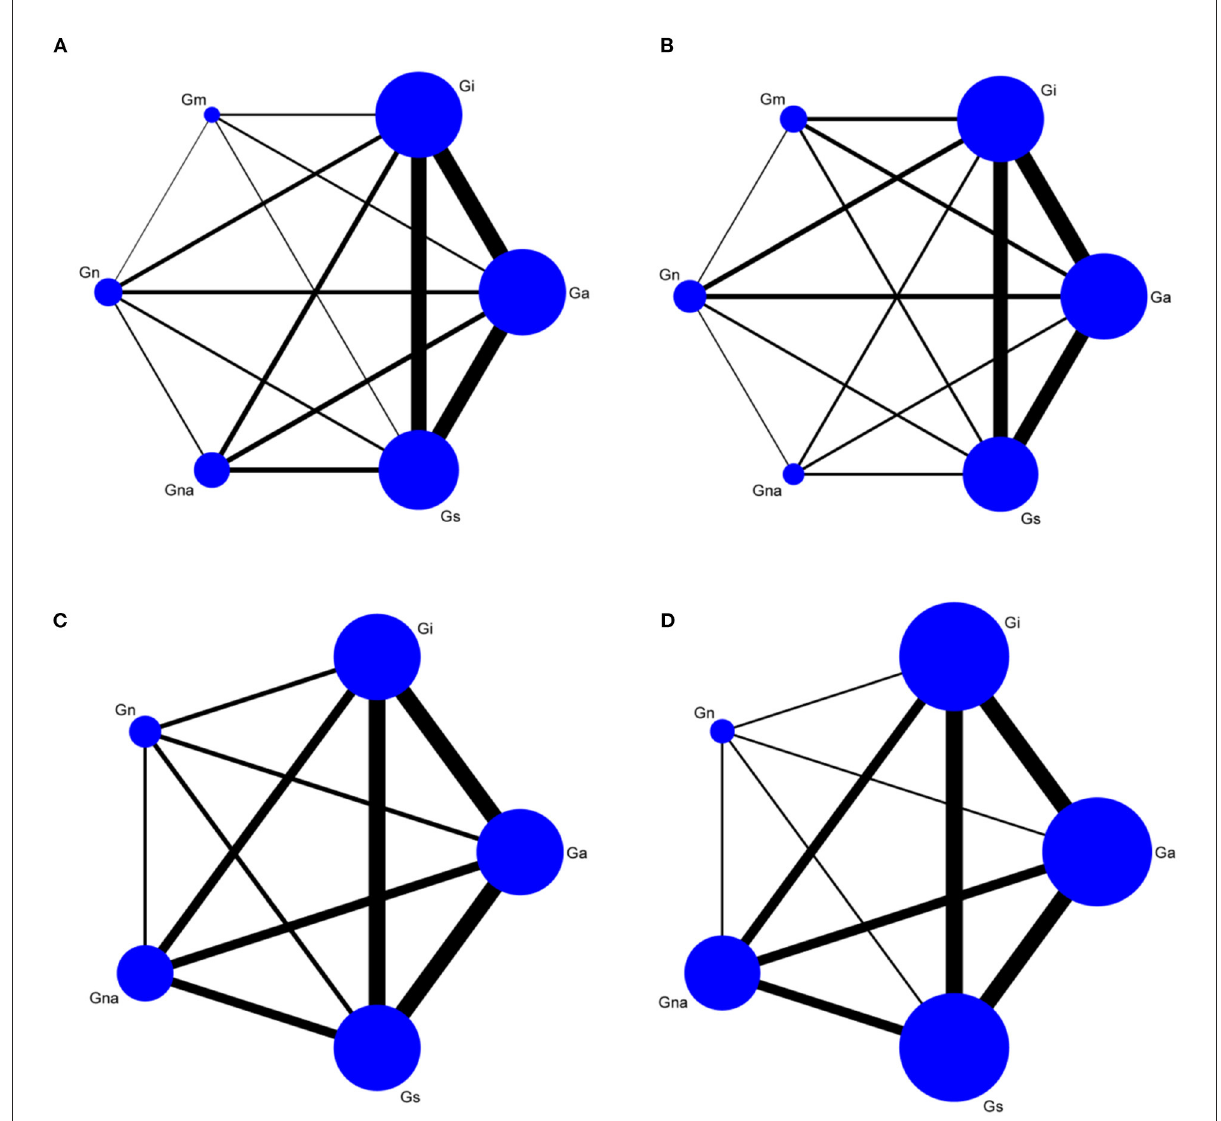
FIGURE2 Network graph of morris water maze. Escape latency (A) , Number of crossings (B) , Time spent in target quadrant (C) , Swimming speed (D) . Gn, Normal group; Gs, Sham-operated group; Gi, Impaired group; Ga, acupuncture group; Gna, Non-acupoint group; Gm, Medicine